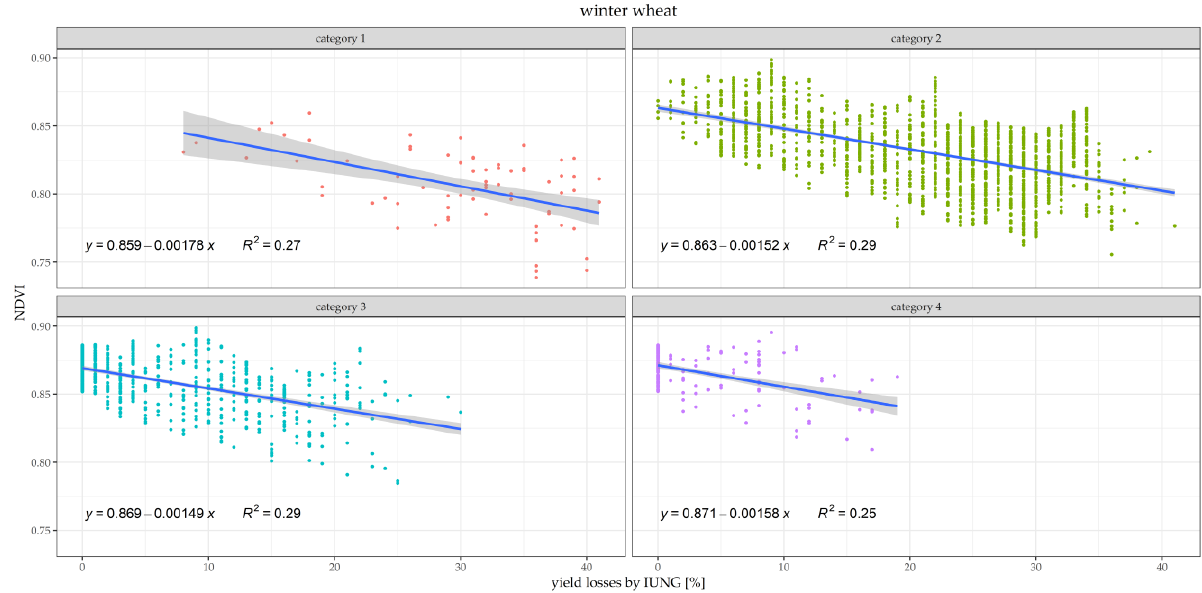
Figure 6. Regression between NDVI values and ADMS results. Source: own study